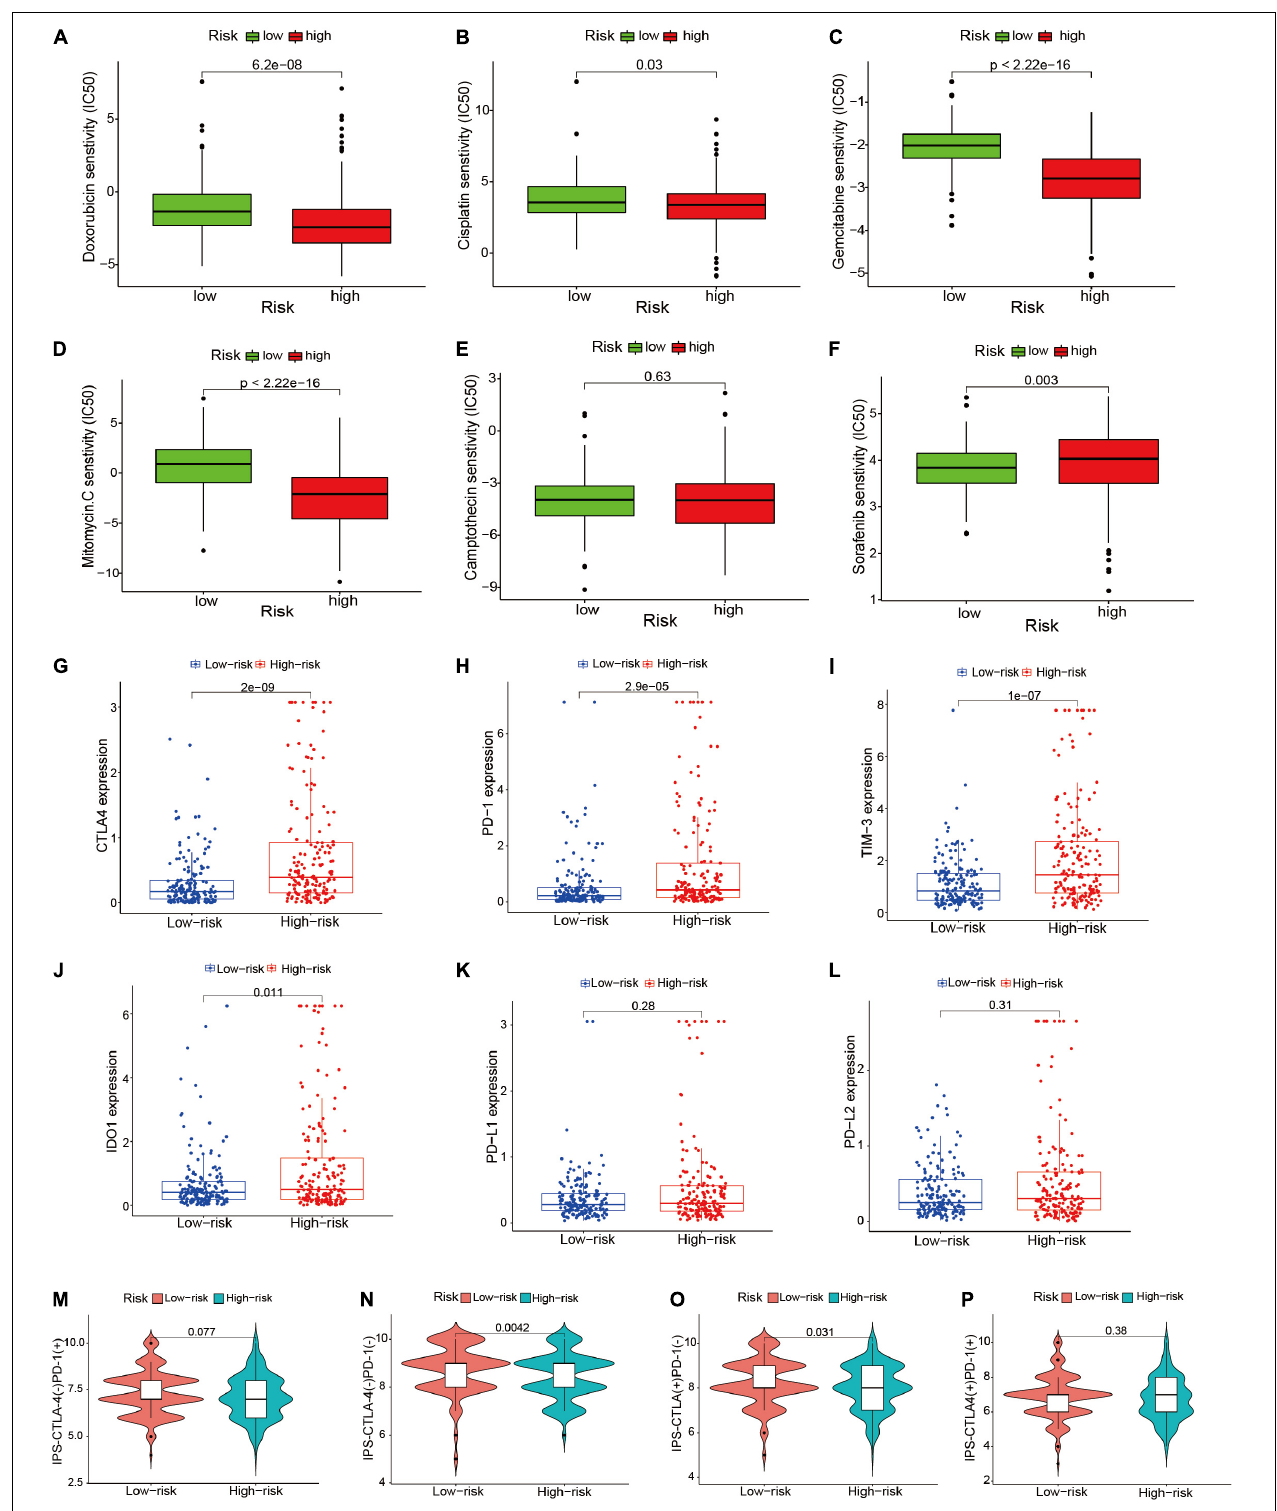
FIGURE 10 | Comparison of treatment drugs sensitivity between high- and low-risk groups. (A–F) IC50 of doxorubicin, cisplatin, gemcitabine, mitomycin C, camptothecin, and sorafenib in high- and low-risk groups. (G–L) The difference of the expression level of CTLA4, PD-1, TIM-3, IDO-1, PD-L1, and PD-L2 between high- and low-risk groups. (M–P) Comparison of the treatment response of ICIs in two risk score groups. ICIs, immune checkpoint inhibitors; IC50, half-maximal inhibitory concentration.